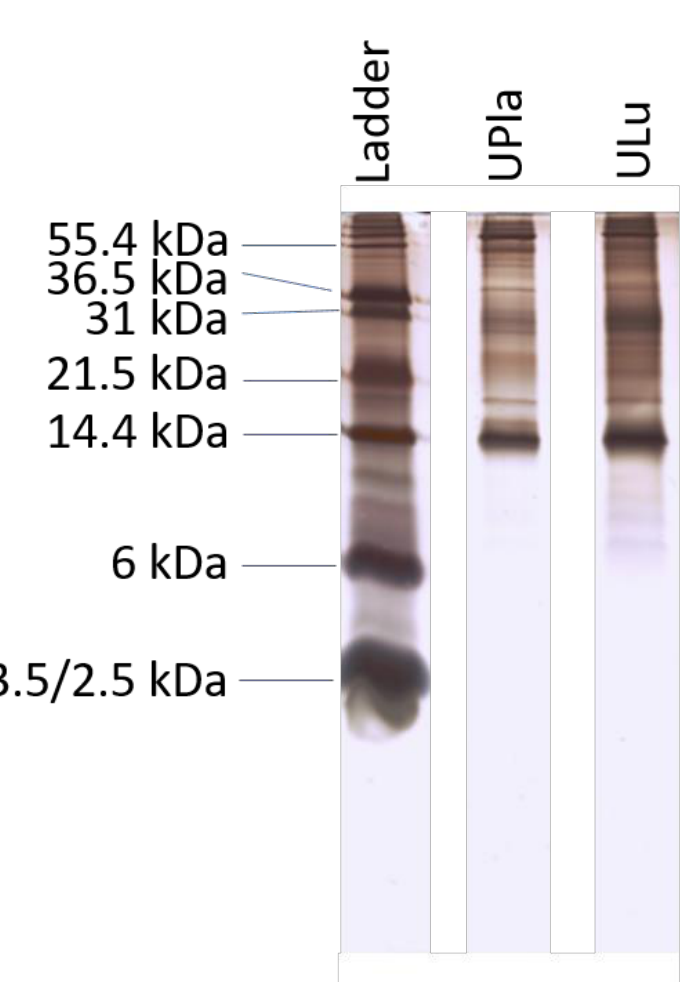
Figure 1. Ultrafiltrates from placenta and lung samples were analyzed by Tris-Tricine–PAGE with a nominal 1 μg per lane. The result is representative of similar results of three independent experi- ments.